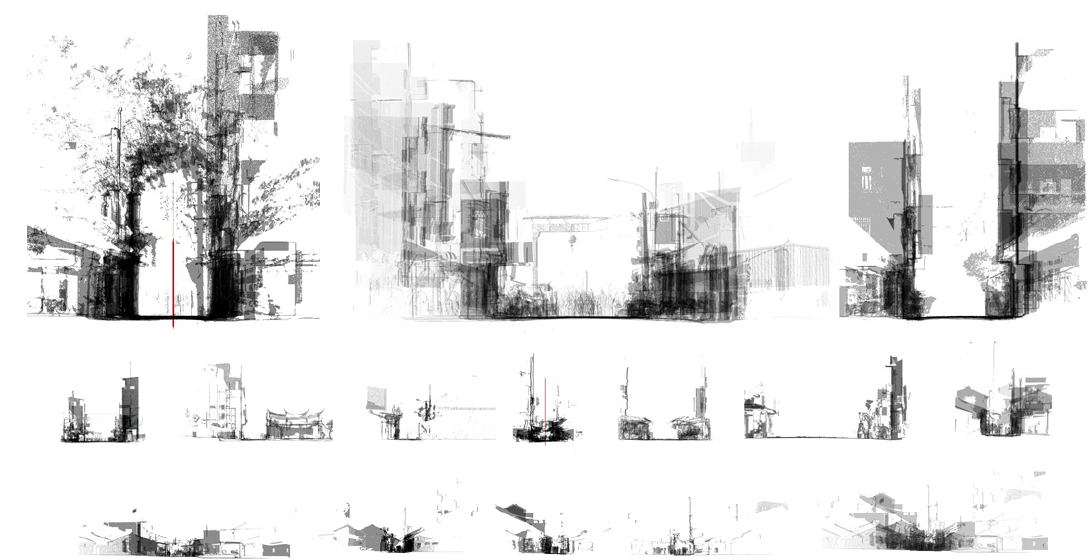
Figure 3. Overlaid sections at every 200 m.